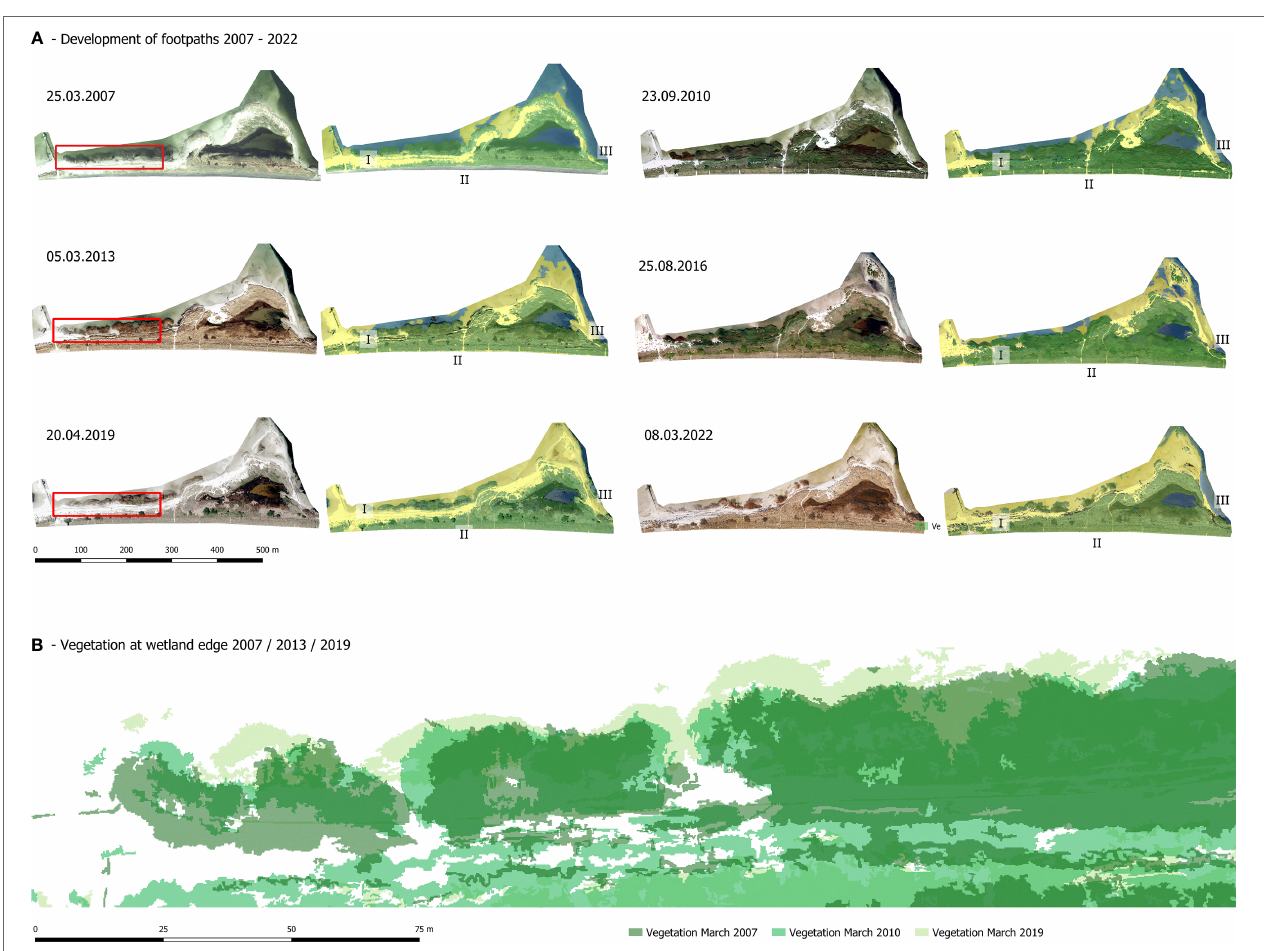
FIGURE 7 | (A) Coastal wetland dynamic between 2007 and 2022. Classification results of the aerial images show that the positions of footpaths remained stable, whereas the widths varied. Locations I–III where the widths of the footpaths were measured are shown in the map. (B) Zoom into the wetland edge for March 2007, March 2013, and March 2019. The picture section is marked in red in (A) . Aerial mages from 2007 to 2019 were provided by the State Office for Surveying and Geoinformation Schleswig-Holstein (LVermGeo